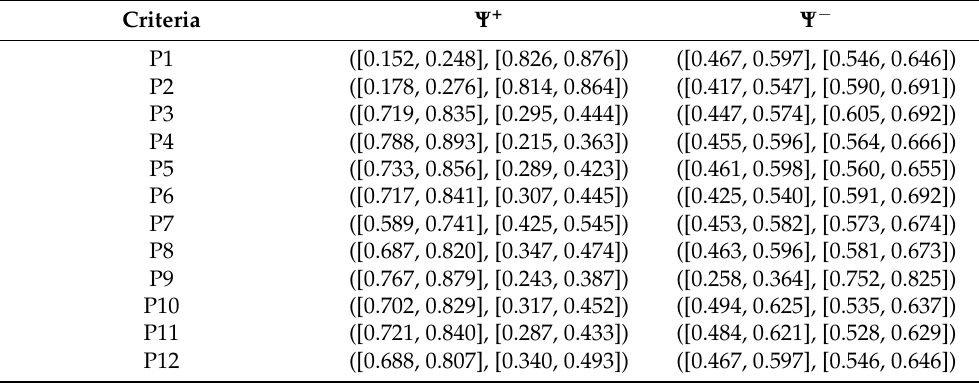
Table 7. IPF-IS and IPF-A-IS WTE technology for MSW treatment